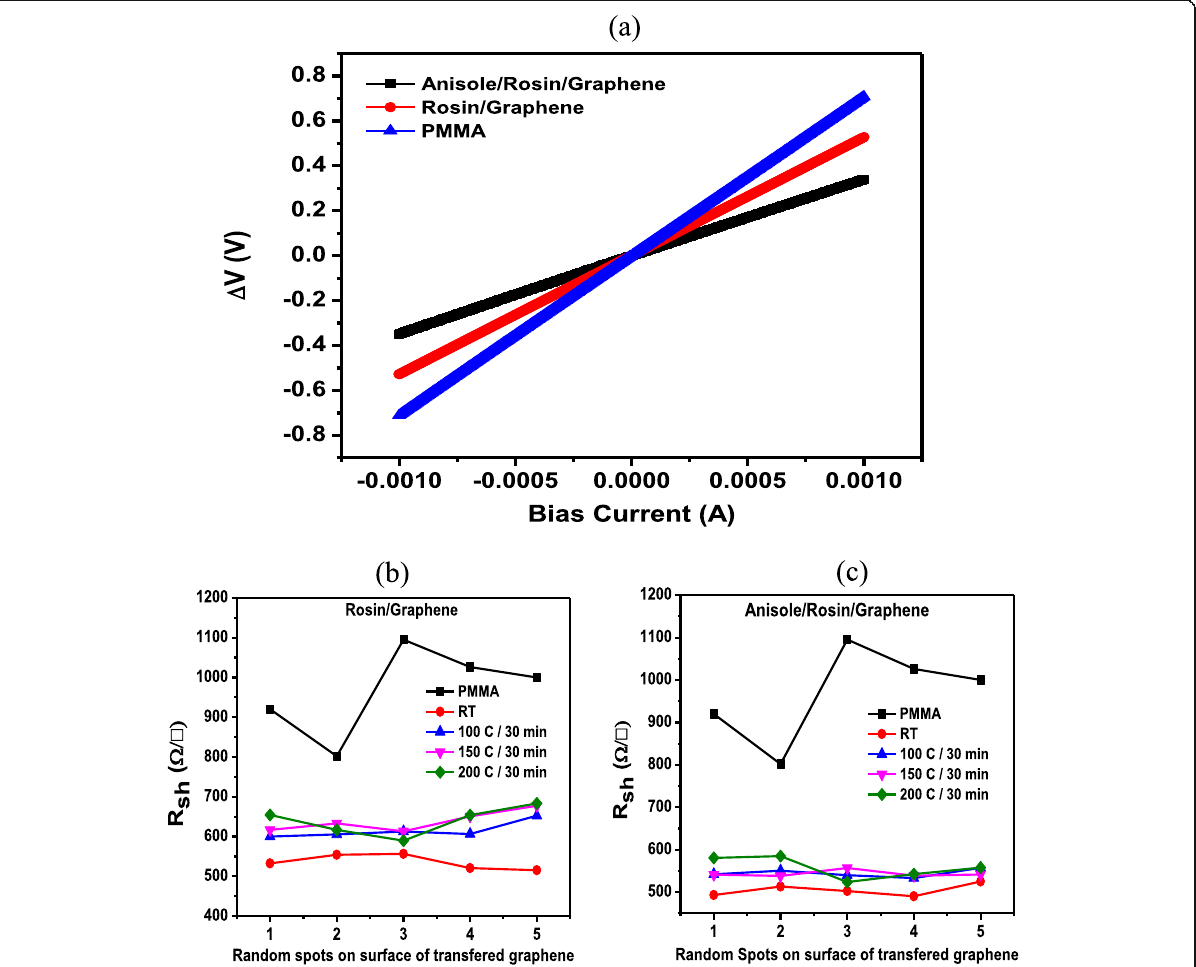
Fig. 8 a I – V characteristic curve for typical transferred graphene by using PMMA, rosin, and anisole/rosin graphene. b Sheet resistance R sh measurement at 5 different random spots of as-transferred graphene by rosin/graphene. c Sheet resistance measurement at 5 different random spots of as-transferred graphene by